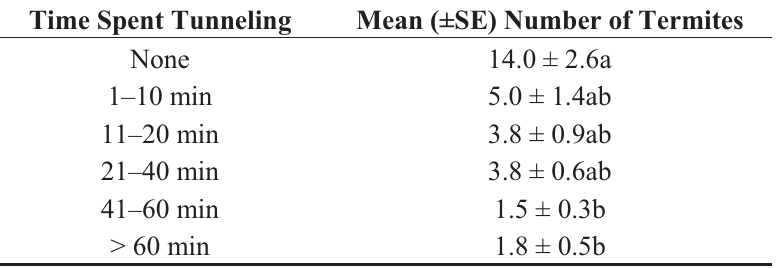
Table 1. Mean (±SE) number of termites that spent time tunneling for different time intervals when the number of minutes each termite spent tunneling on both days was combined. Trials were conducted on consecutive days with the same group of 30 workers with two groups from each colony.